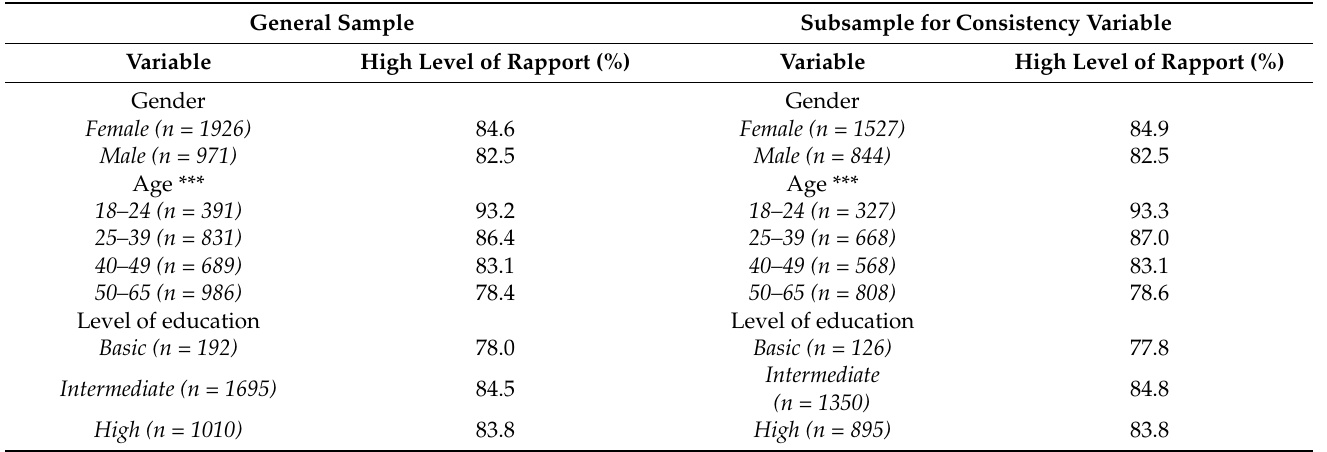
Table 1. Demographics of the NESDA